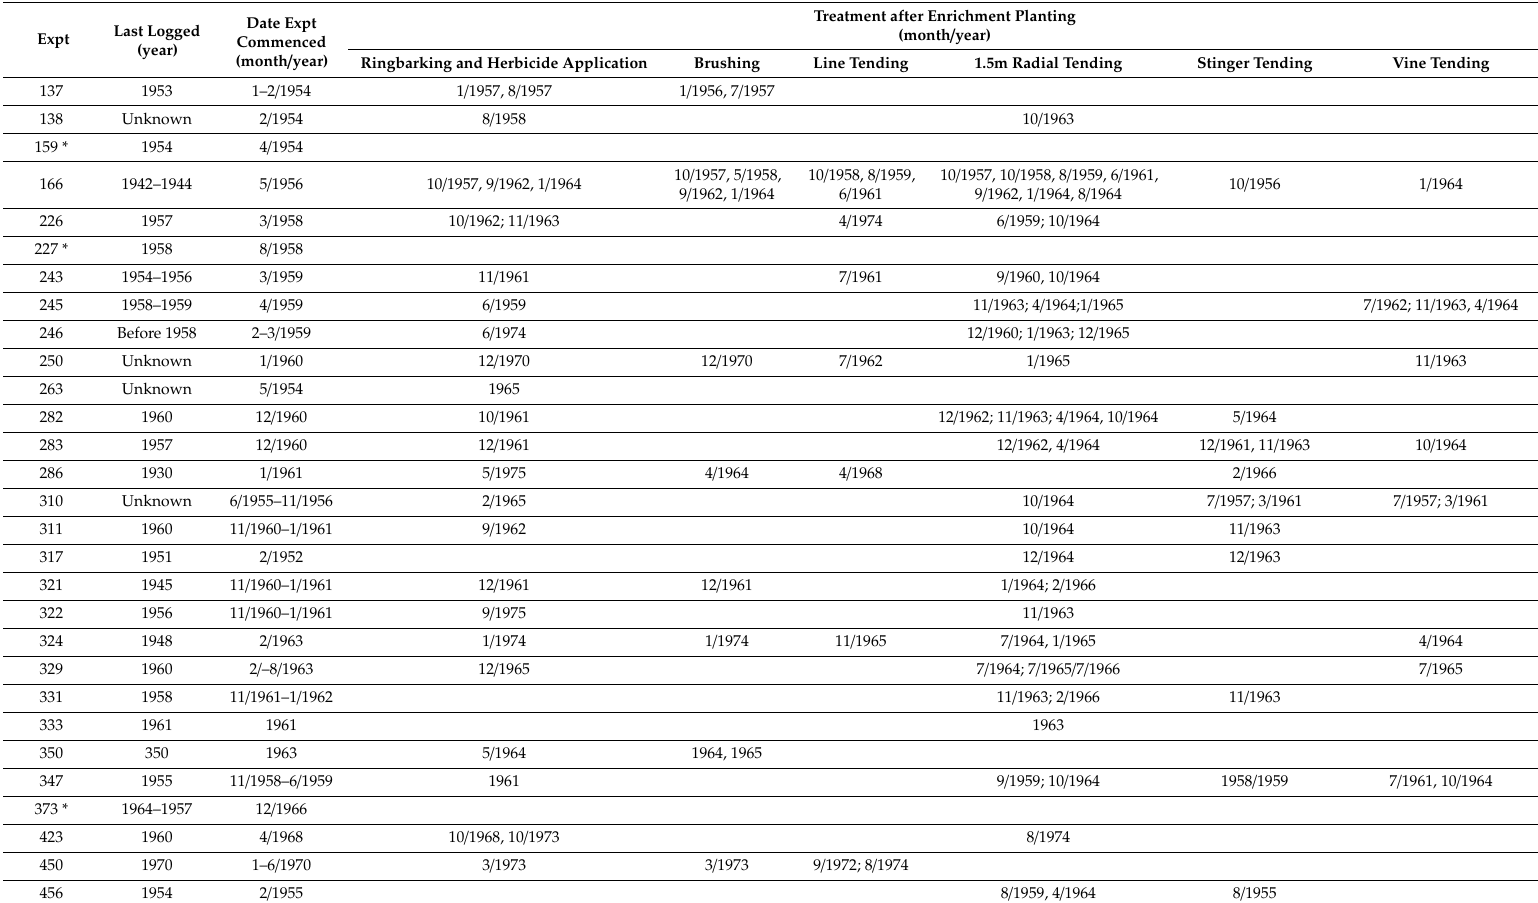
Table A2. Post-planting silvicultural treatments carried out in the enrichment planting experiments in north